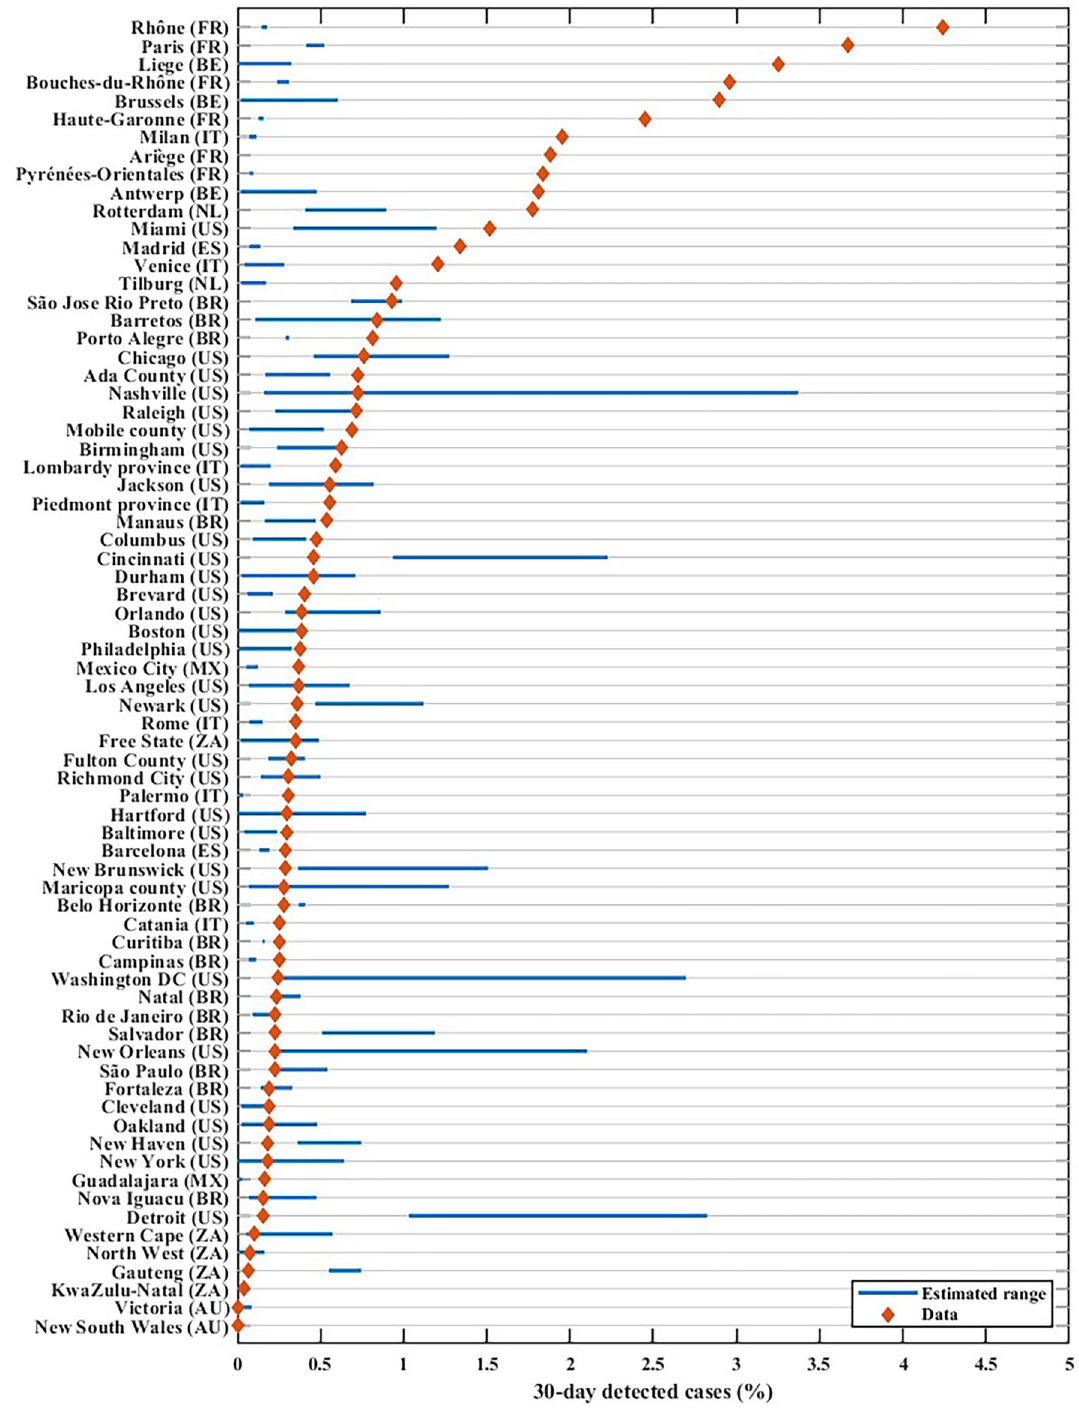
Figure 3. 30-day detected COVID-19 cases for September 15 to October 31, 2020, sorted by data in descending order. The blue line represents the estimated range from the simulations, and the red diamond the